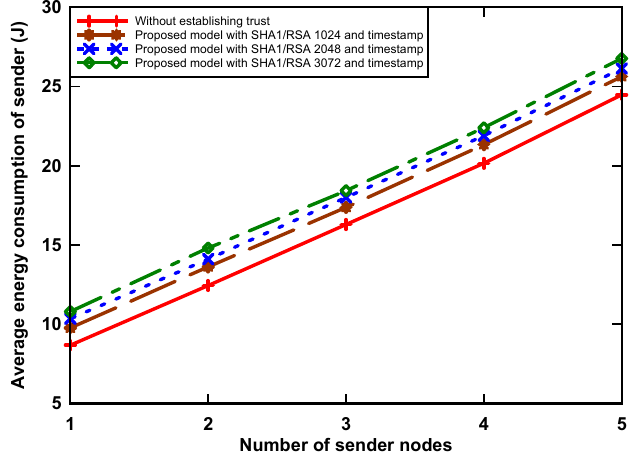
Figure 5. Average energy consumption of sender nodes.